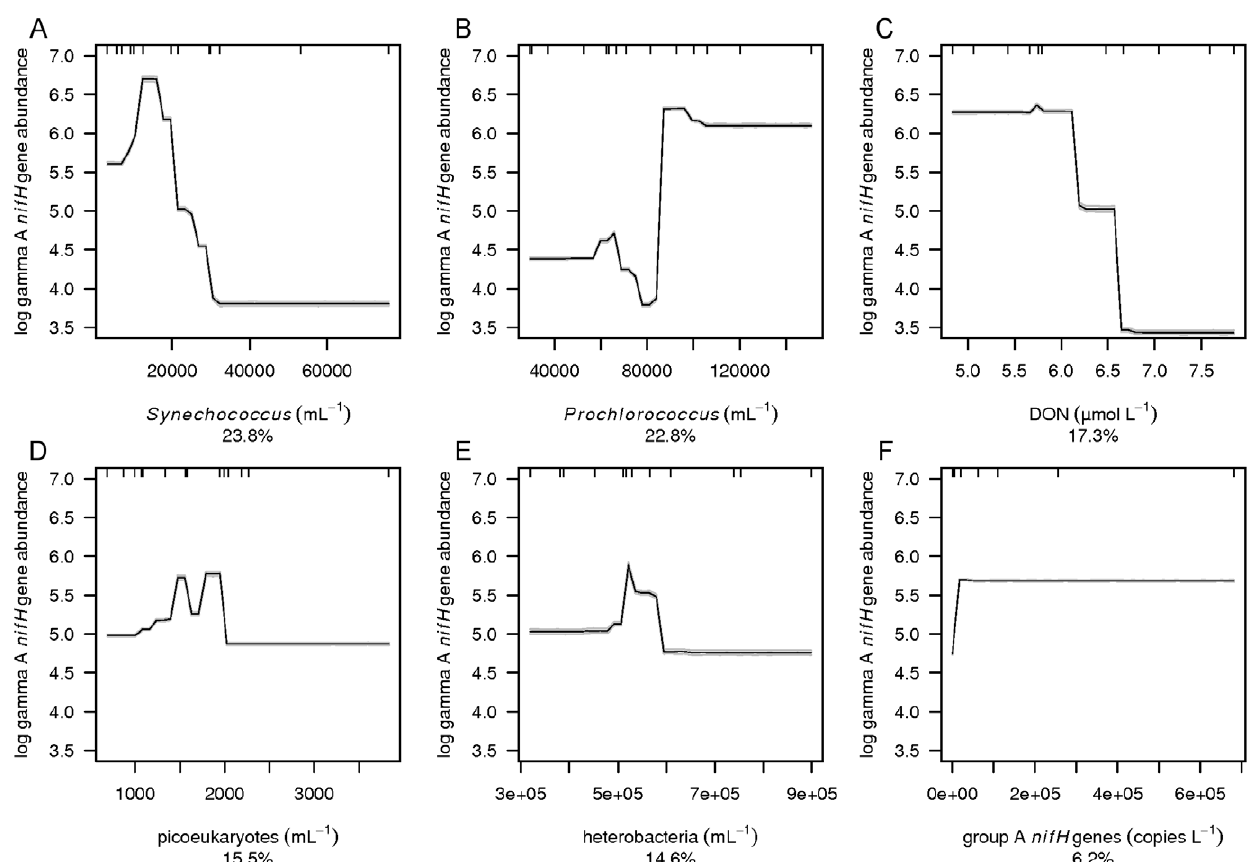
Figure 6. Mean partial dependence plots for the environmental variables describing the gamma A nifH gene abundance. Mean partial dependence plots with 95% confidence intervals (light grey, based on bootstrapping of 30 BRT runs and indicating robustness of model performance) for the 6 environmental variables best at explaining the variation in gamma A nifH gene abundance. The 6 environmental variables are A) Prochlorococcus , B) Synechococcus , C) heterotrophic prokaryotes, D) picoeukaryotes, E) DON and F) group A nifH genes. The y-axis is centered to have zero mean over the log distribution of the fitted gamma A nifH gene abundance. A common scale is used for the x-axis. Rug plots at inside top of plots show the distribution of sites across that variable, in